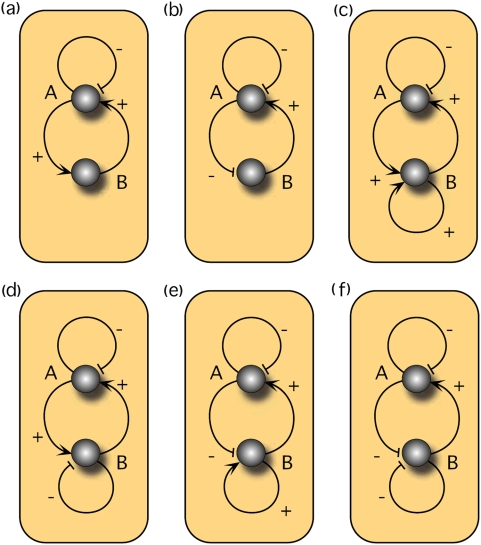
All possible regulatory combinations preventing bistability.In other circuit topologies the emergence of bistability is possible but conditioned to the specific parameters of the system.